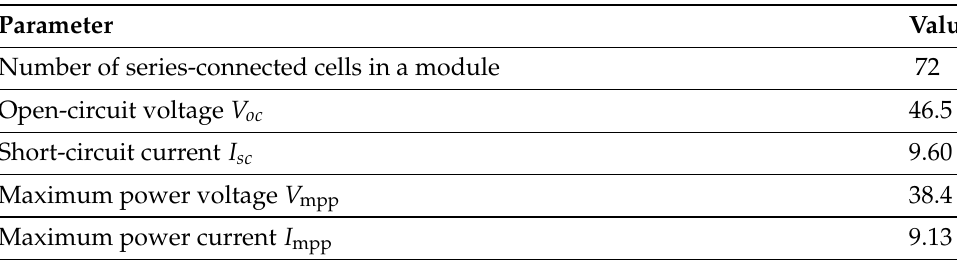
Table 3. The used parameter values for one single